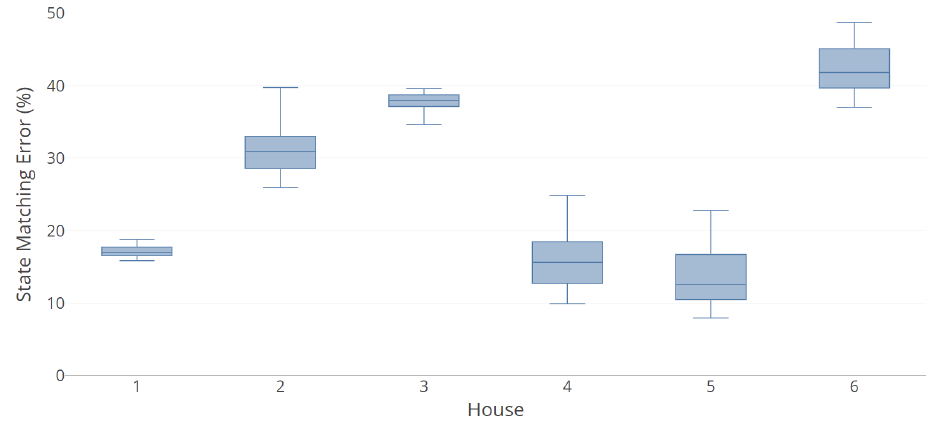
Figure 6. State matching error for each house [%].